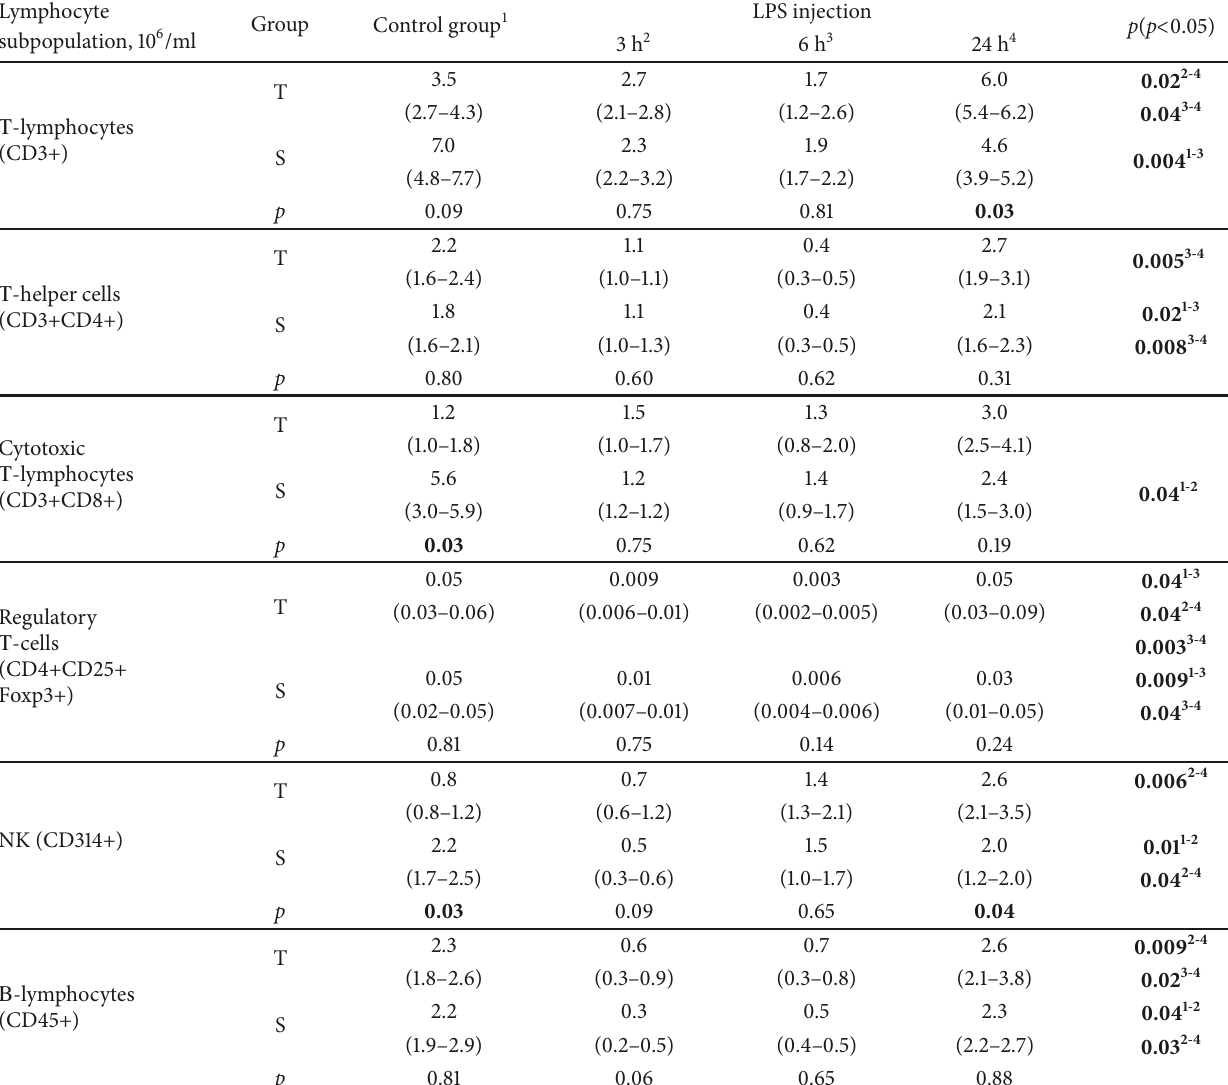
Table2:Subpopulationoflymphocytesintheperipheralbloodoftolerant-(T)andsusceptible-(S)to-hypoxiaWistarratsin3,6,and24hours after LPS injection. Data are presented as median (25%, 75%); the statistical significance of differences ( p ) between tolerant and susceptible rats is determined by the Mann-Whitney U test and between different time points after LPS injection by the Kruskal-Wallis method ( 𝑛 = 5 in each